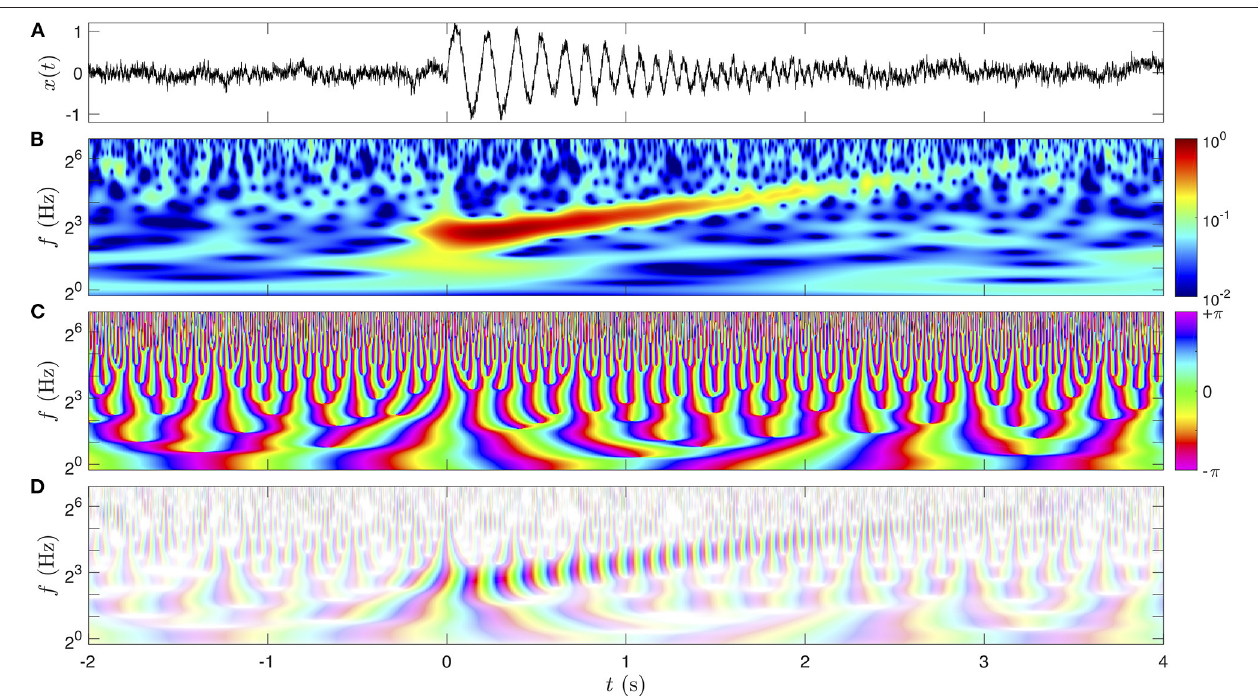
FIGURE 2 | Graphical representations of the CWT on a pedagogical signal x ( t ). The signal x ( t ) is represented in (A) , and its CWT (Equation 4) of quality factor Q computed. The amplitude is color-coded in a logarithmic scale in (B) , and the phase with the chromatic circle in (C) . Note that we represented twice the amplitude of the CWT in (B) so that it is directly comparable to the amplitude of the time signal (A) . Both dimensions of the complex value of the CWT are combined in (D) with a two-dimensional shaded-color coding: the phase is still associated to a hue in the chromatic circle and the amplitude is coded by the saturation of the